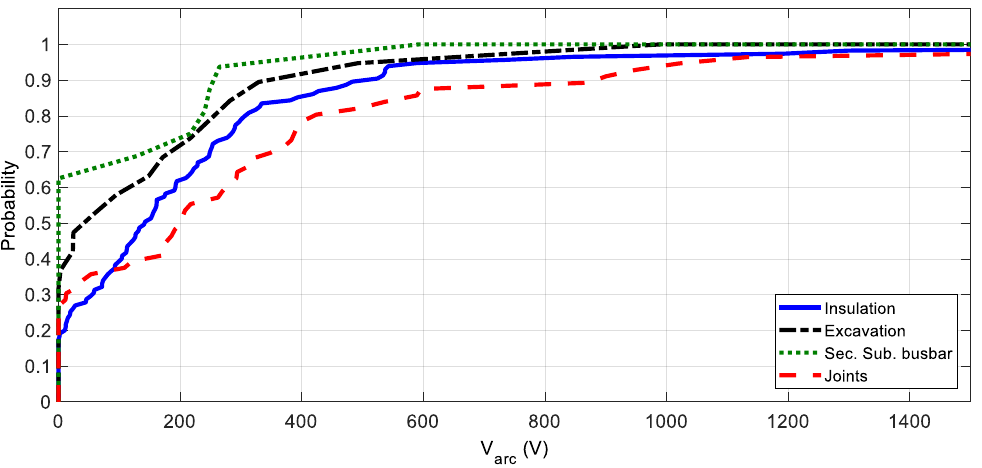
Figure 7. Observed cumulative probability for the arc voltage.